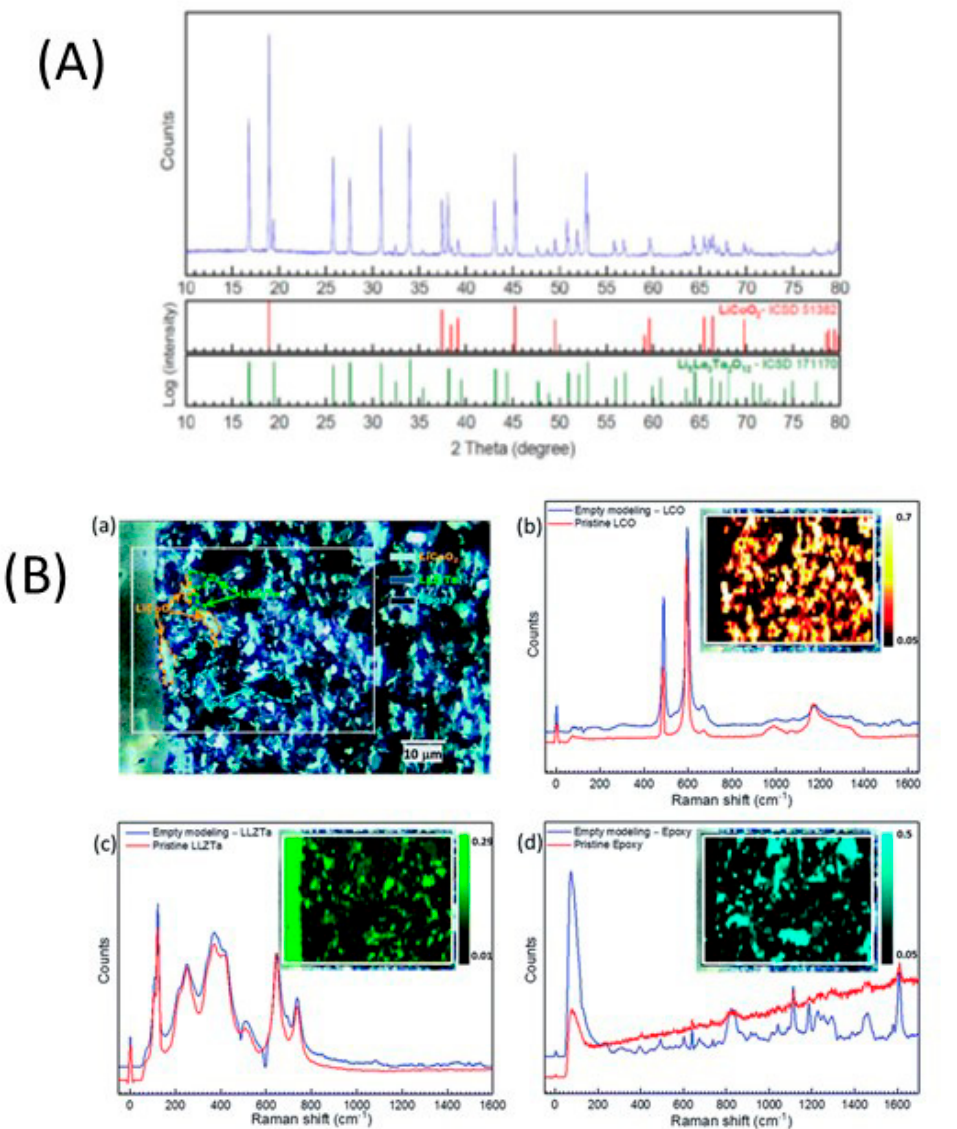
Figure 25. ( A ) X-ray di ff raction patterns of LiCoO 2 / Li 6.6 La 3 Zr 1.6 Ta 0.4 O 12 composite cathode with the mass ratio of 1:1 that was sintered at 1050 ◦ C for 30 min in air. ( B ) High-resolution micro-Raman mapping of the cross-section of the ASSLB. ( a ) Optical image of the ASSLB cross-section and its mapping area. Raman mappings and spectra of ( b ) LiCoO 2 , ( c ) Ta-LLZO, and ( d ) epoxy. Reproduced with permission from [13]. Copyright 2019 Royal Society of Chemistry.